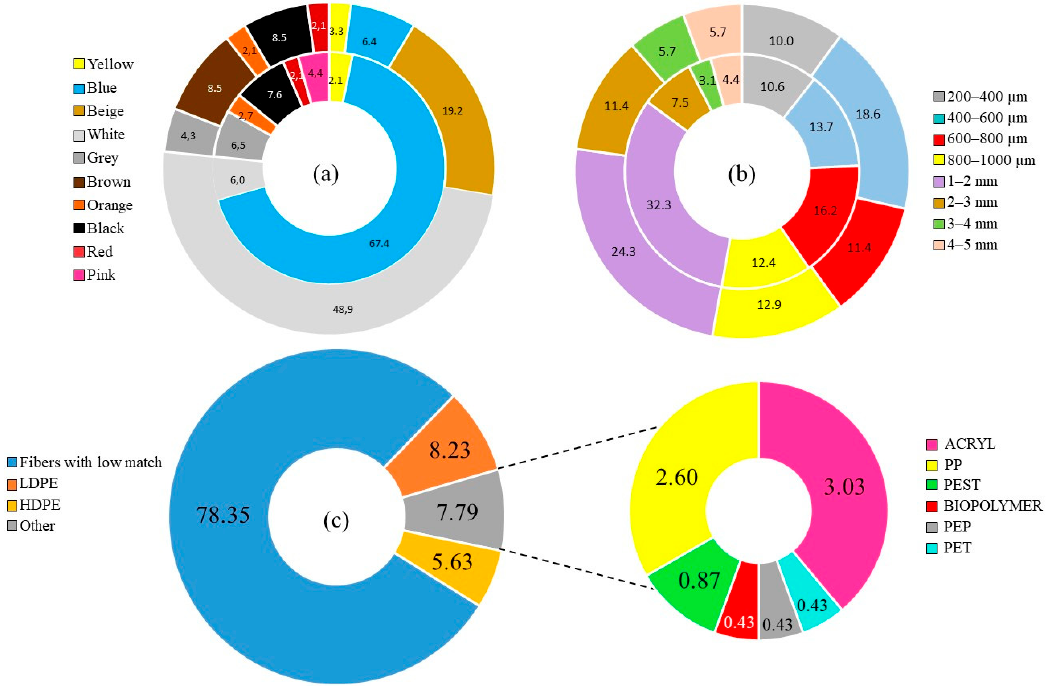
Figure 4. Accumulated percentages across the WWTP: ( a ) colors by microplastics shape: Inner ring means FB, outer ring represents MPP; ( b ) size categories based on Spanish Environmental Ministry classification: Outer ring represents EFF; ( c ) polymer types identified by FTIR, including fibers with a low percentage match.